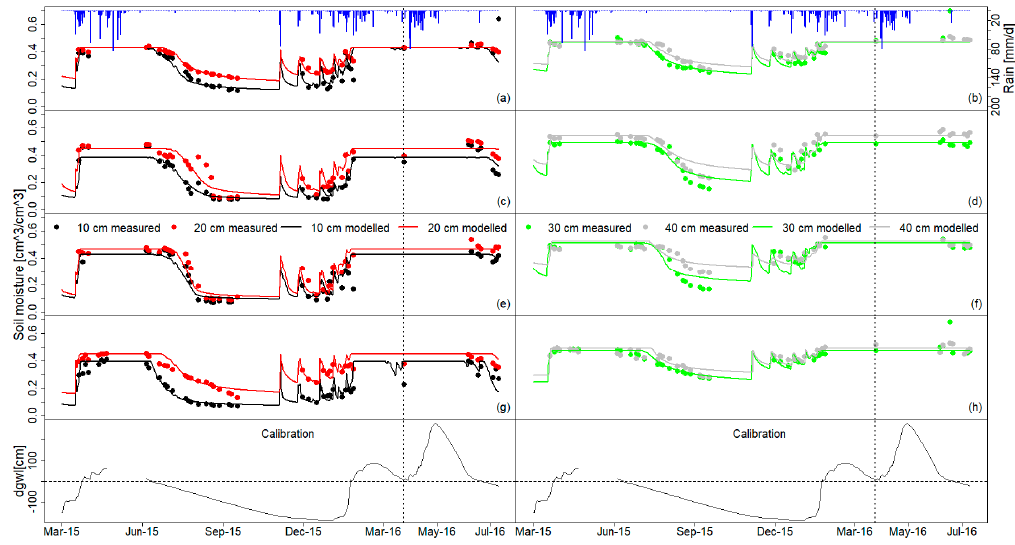
Figure 3. Measured and modeled soil moisture content for calibration at the four plots in the riparian zone. ( a , b ) plot PR_4; ( c , d ) plot PR_1; ( e , f ) plot PR_8; ( g , h ) plot PR_3. dgwl, measured depth to groundwater level.